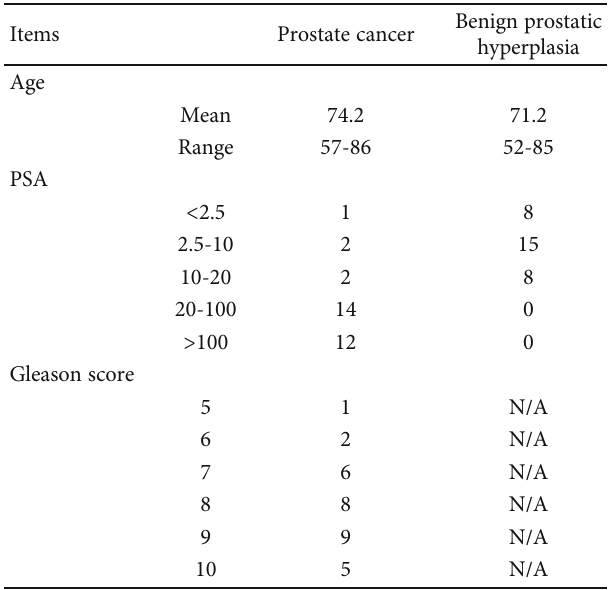
Table 2: Clinical status of prostate subjects and benign prostatic hyperplasia